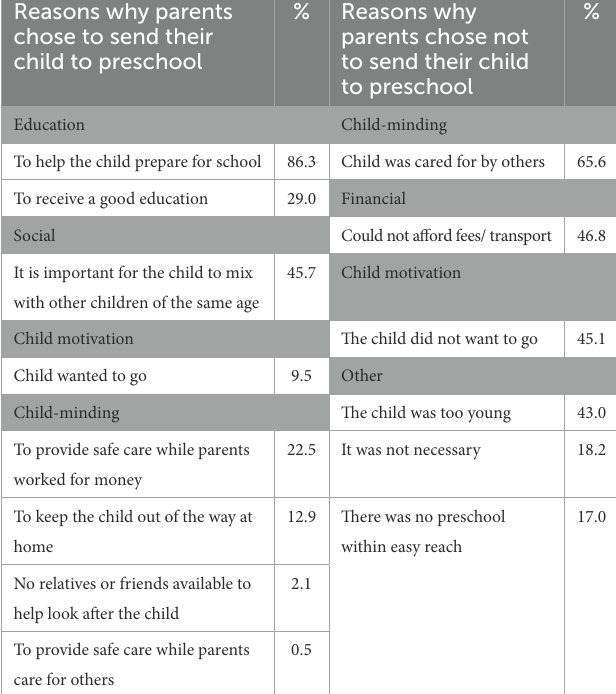
TABLE 7 Vietnamese parents’ self-reported reasons for choosing to send, or not send, their child to preschool. Reasons why parents chose to send their child to